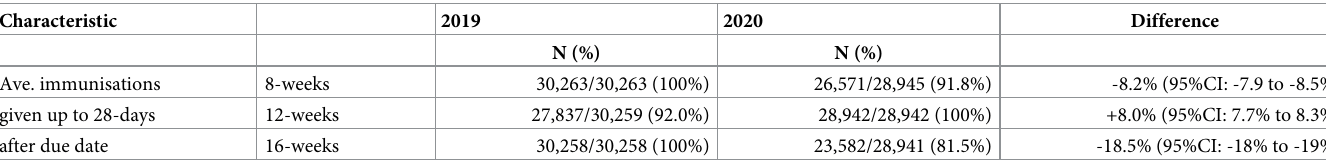
Table 5. Primary immunisations scheduled for 8-, 12-, and 16-weeks given on time (within 28 days of their due date).